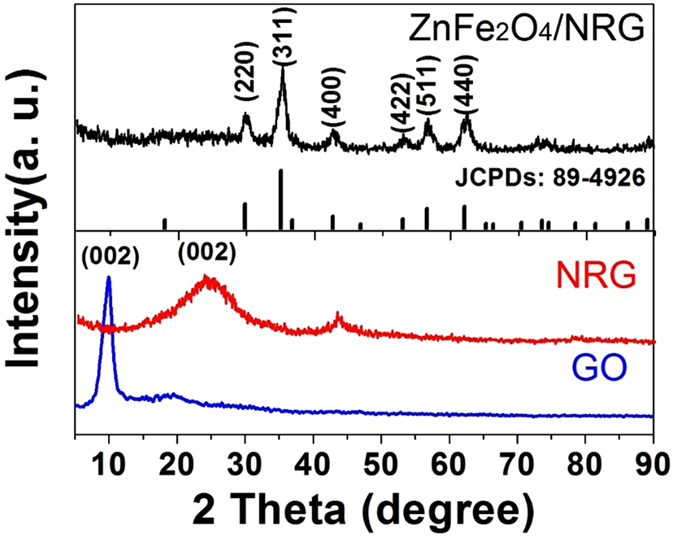
XRD patterns of GO (a), NRG (b), and ZnFe2O4/NRG (c) composite.